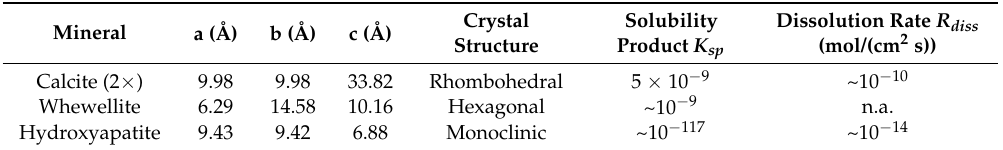
Table 1. Comparison between lattice parameters and crystal structure [25,26], solubility product in water at 25 ◦ C ( K sp ) [22,27,28] and dissolution rate in water at pH 5.6 ( R diss ) [29,30] of calcite, whewellite and hydroxyapatite. For calcite, two molecules for unit cell are considered to show the match in lattice parameters with hydroxyapatite. For hydroxyapatite, the solubility product is estimated as ~10 − 117 [22] or ~10 − 58 [31], depending on whether the Ca 10 (PO 4 ) 6 (OH) 2 or the Ca 5 (PO 4 ) 3 (OH) formula is considered, respectively. (n.a. = not